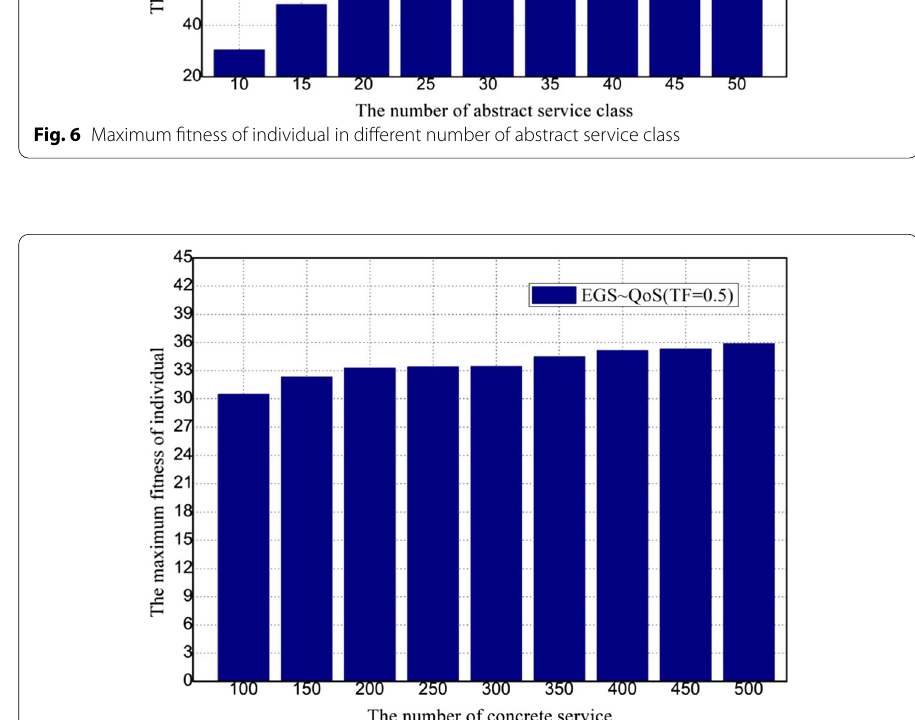
Fig. 7 Maximum fitness of individual in different number of concrete service